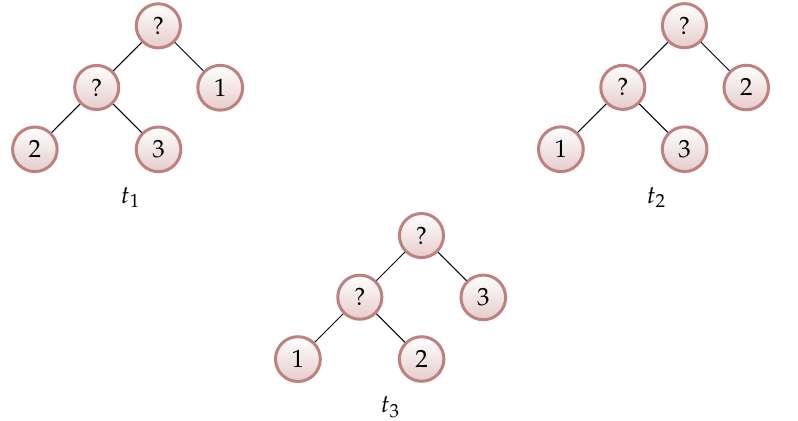
Figure 3. Balanced tournaments with three players.